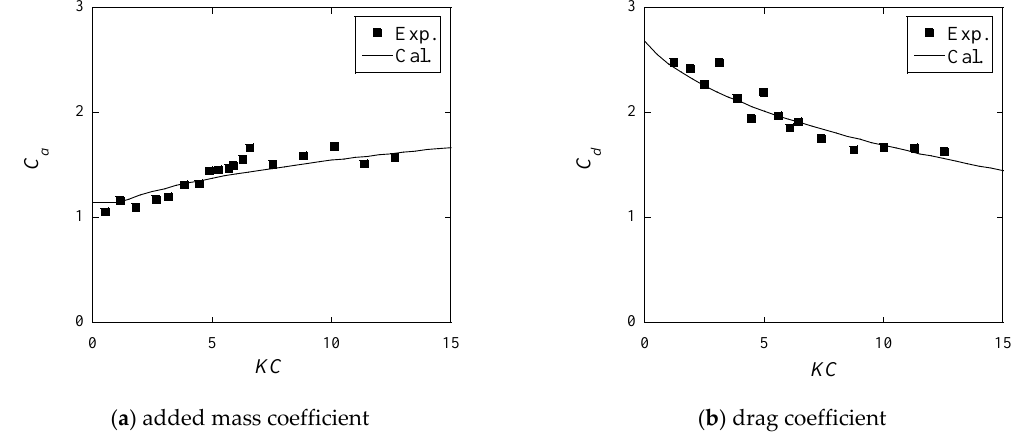
Figure 4. Variation of ( a ) added mass and ( b ) drag coefficients of a square cylinder with KC number in the oscillatory flow.